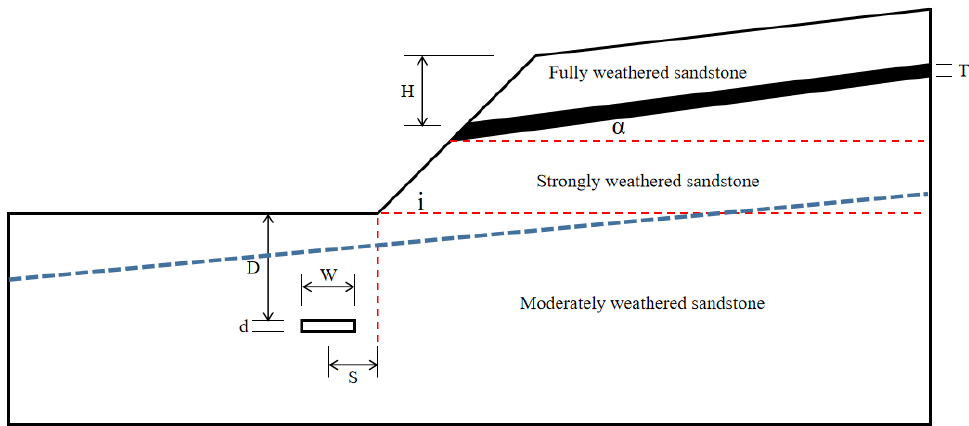
Figure 2. Schematic diagram of the influencing factors. i is the slope gradient, T is the coal seam thickness, α is the coal seam dip angle, H is the coal seam position (that is, the distance between the coal seam exposed on the slope surface and the top of the slope), S is the roadway position (that is, the horizontal distance between the roadway center and the slope foot), and W is the roadway width. Blue dotted line is the boundary line of the rock strata.